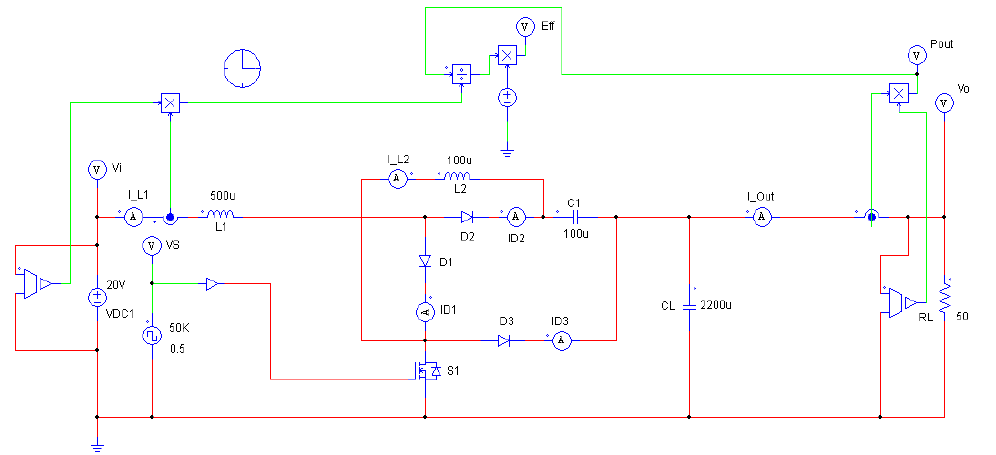
Figure 4. PSIM implementation schematic of the proposed converter.